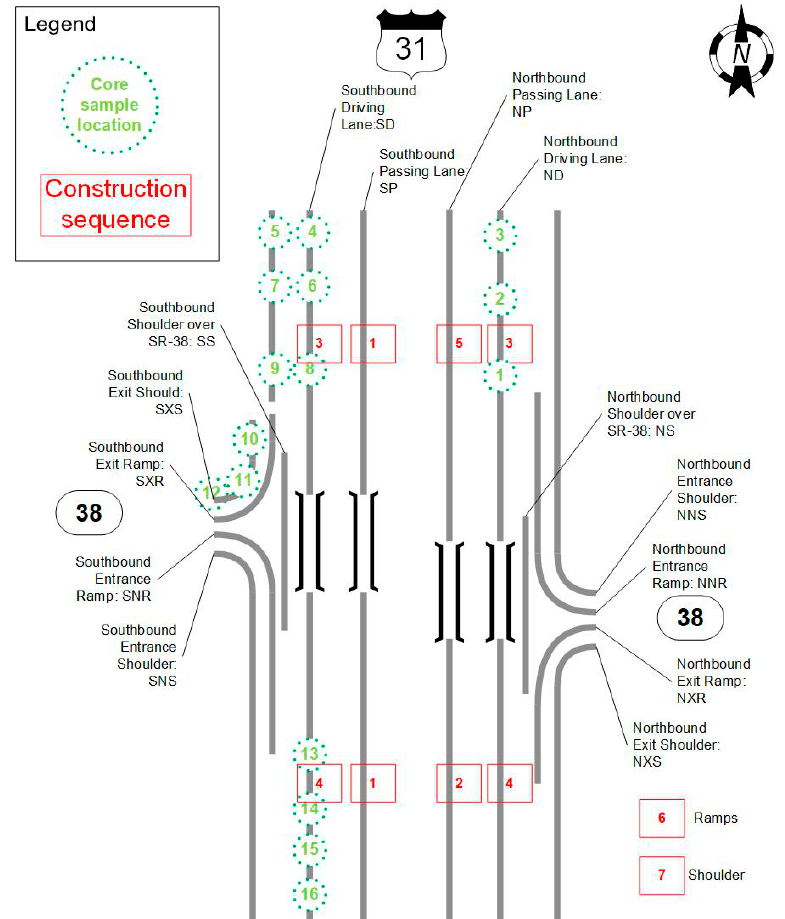
Figure 2. Schematic of US-31 and SR-38 with core location and construction sequence.